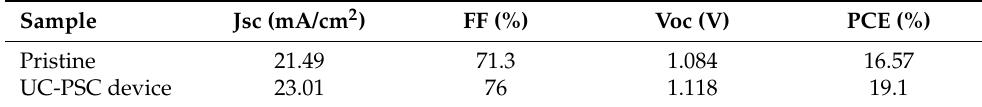
Table 1. Photovoltaic parameters of the fabricated